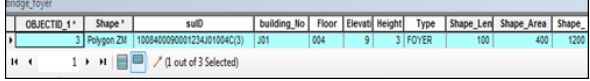
Figure 9. The result of query in table bridge_foyer